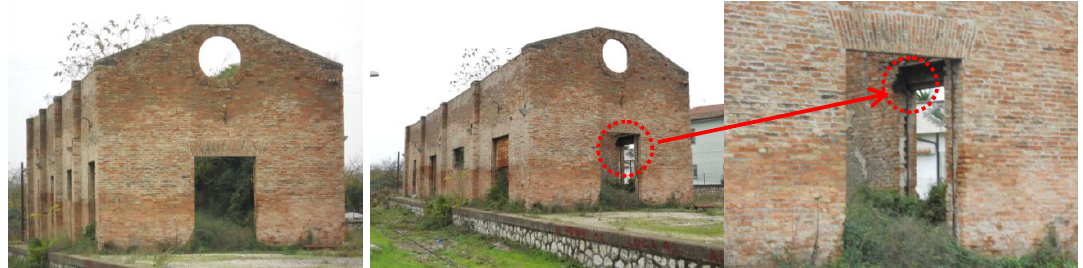
Figure 2. Warehouse (from which the old-1 bricks were extracted).